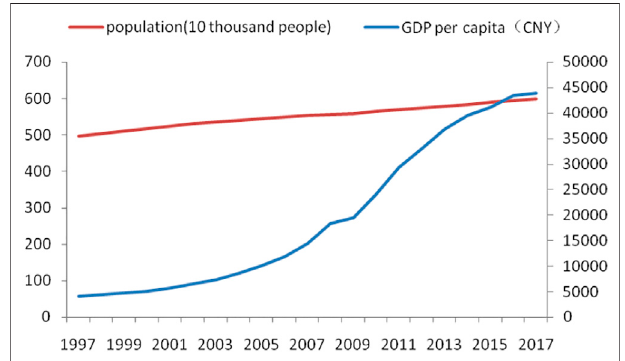
FIGURE 4 | Changes in per capita real GDP and population in Qinghai